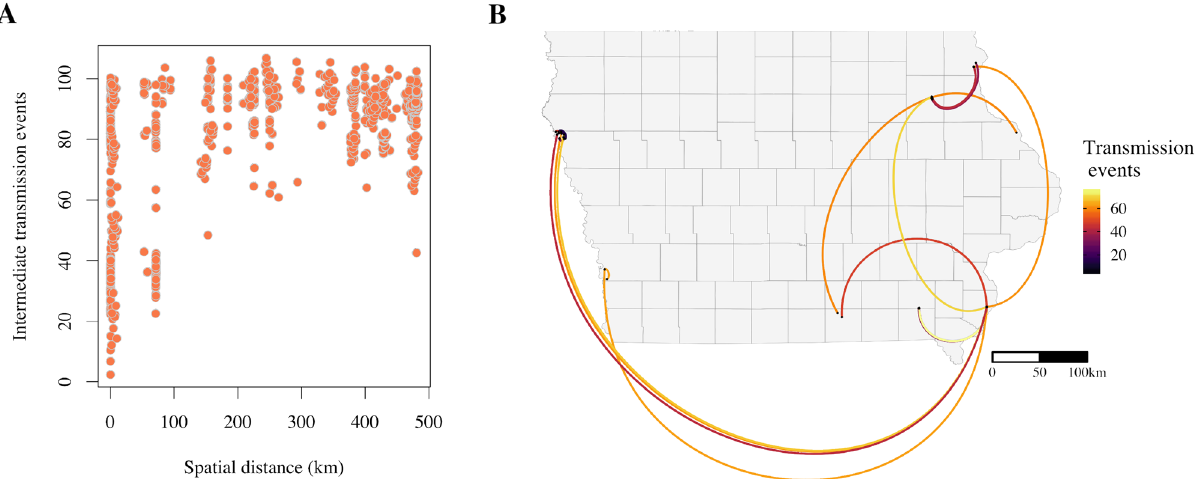
Figure 4. ( A ) Geographic distance and mean inferred number of transmission events between each pair of sampled deer. ( B ) Map of Iowa, United States, showing the geographical location of SARS-CoV-2 deer samples and links to the nearest deer in number of transmission